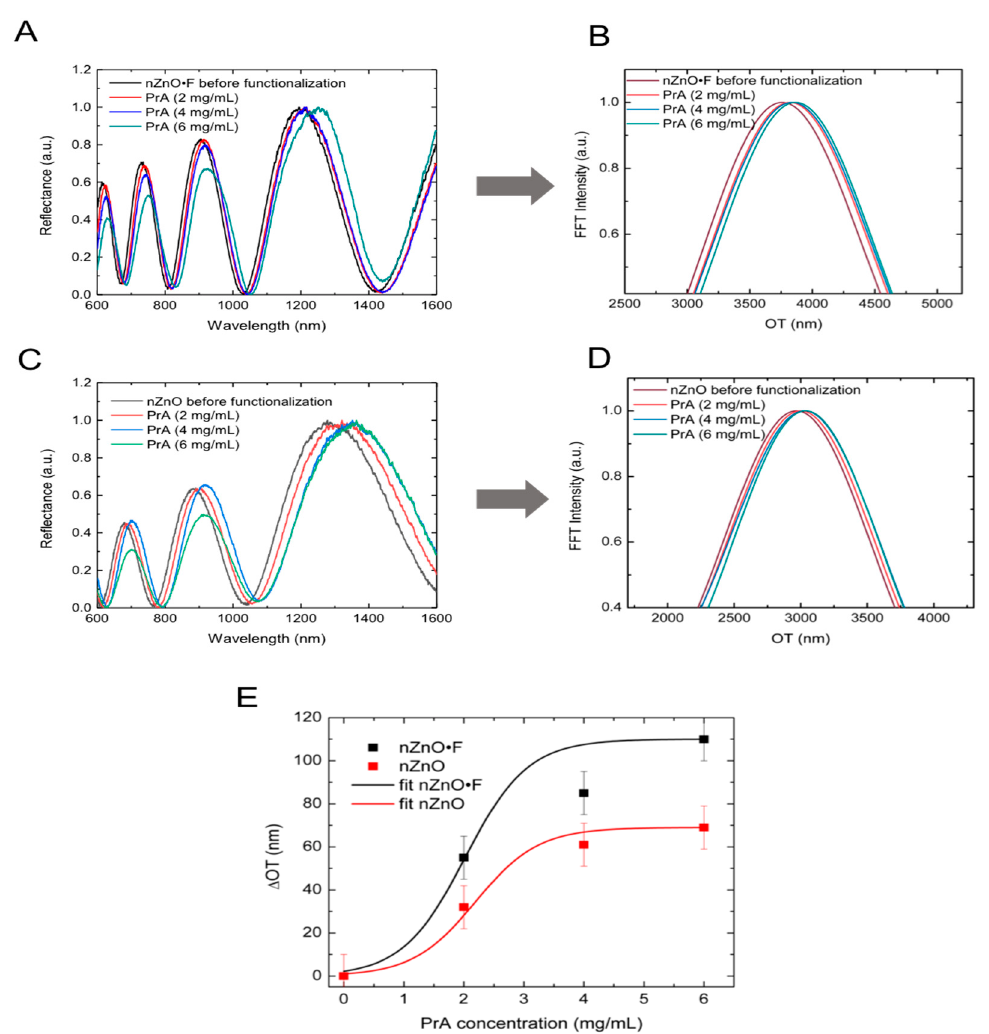
Figure 5. Reflectivity spectra of nZnO·F ( A ) and nZnO ( C ) before and after modification with different concentrations of PrA; corresponding Fourier transforms ( B , D ). ∆ OT as function of PrA concentrations, calculated for nZnO·F and nZnO; experimental data were fitted by using a dose- response curve ( E ).